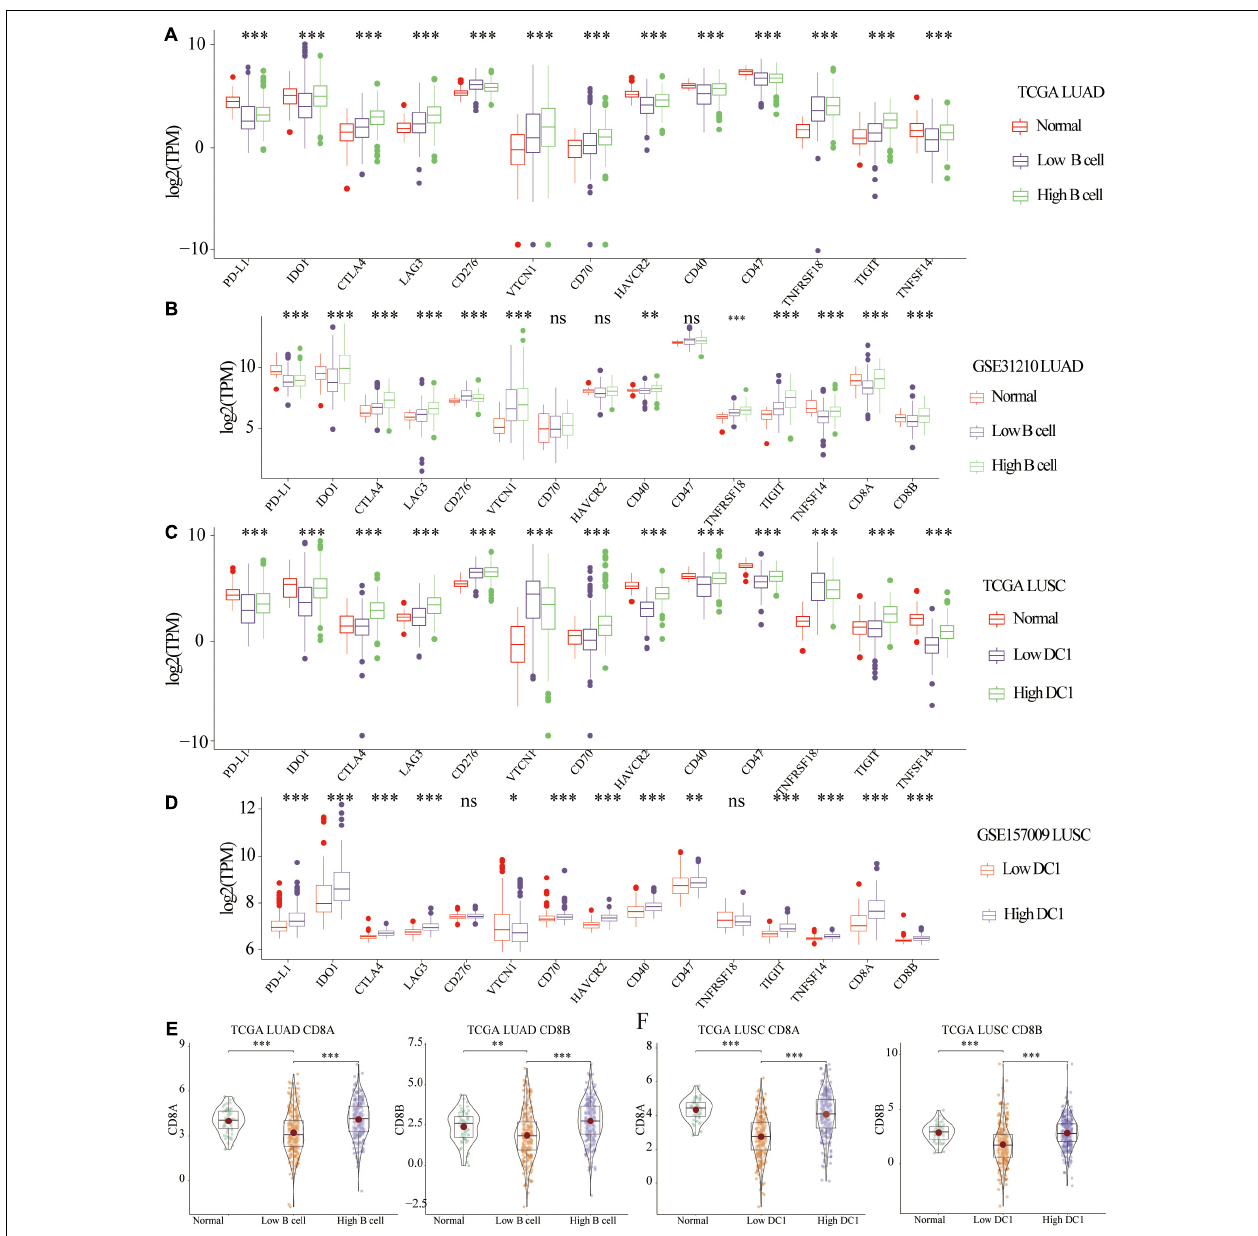
FIGURE 4 | Expression profiles of adaptive immune resistance markers and CD8A and CD8B in LUAD and LUSC. Differential expression of adaptive immune resistance markers among normal, low, and high B cell groups in (A) TCGA LUAD and (B) GSE31210 LUAD cohorts. Differential expression of adaptive immune resistance markers among normal, low DC1, and high DC1 groups in (C) TCGA LUSC and (D) GSE157009 LUSC cohorts. Differential expression of CD8A and CD8B in (B) GSE31210 LUAD, (E) TCGA LUAD, (D) GSE157009 LUSC, and (F) TCGA LUSC cohorts. ∗ p < 0.05 ∗∗ p < 0.01, ∗∗∗ p < 0.001.